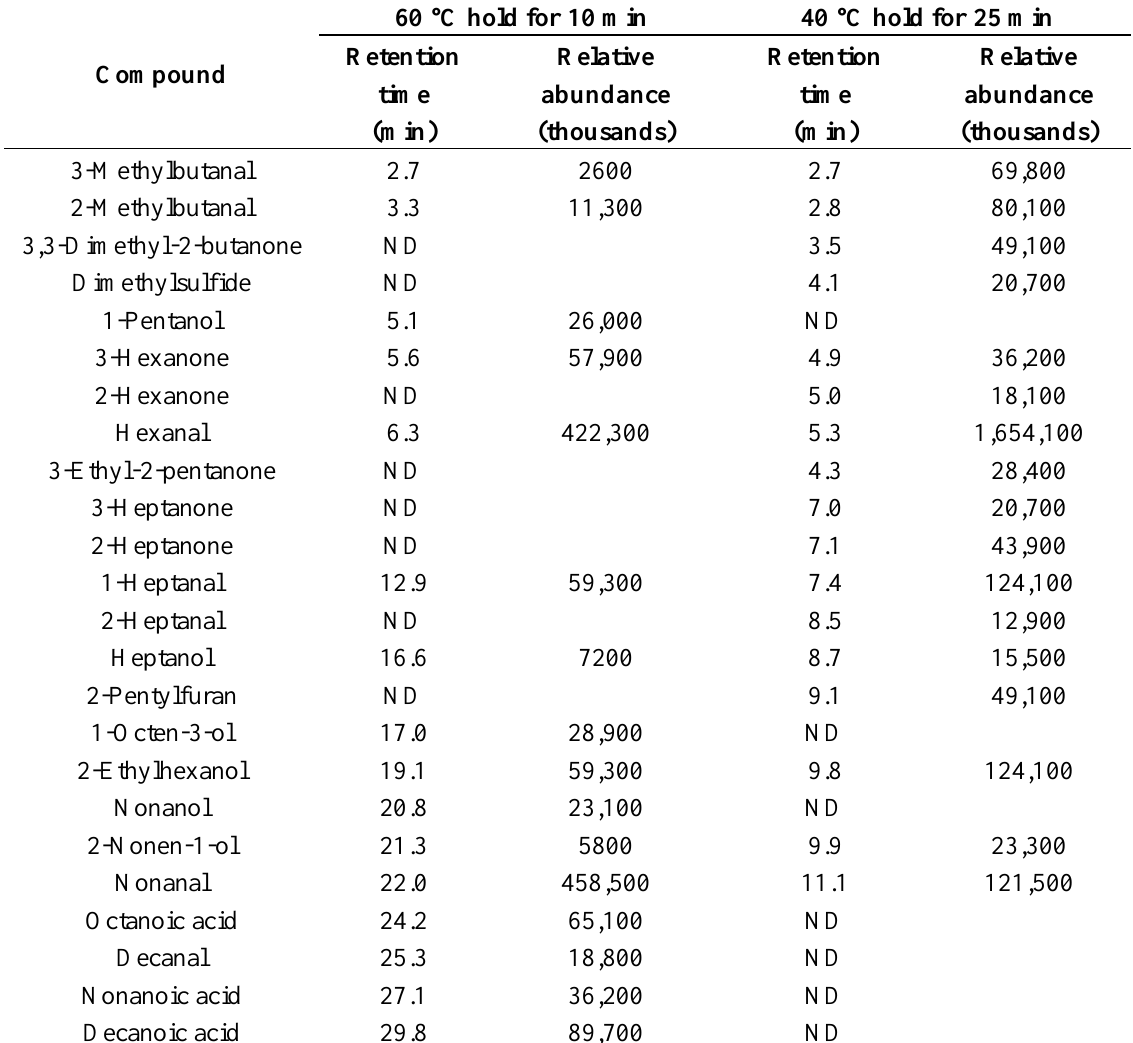
Table 6. Relative abundance of volatile compounds in whey protein concentrate, and variations with temperature conditions. ND = not